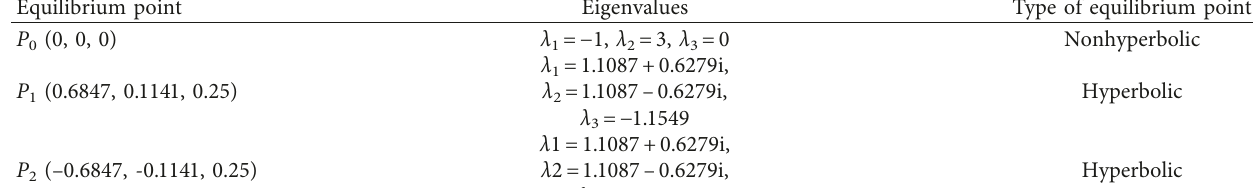
Table 1: Equilibrium points and eigenvalues of system (1).